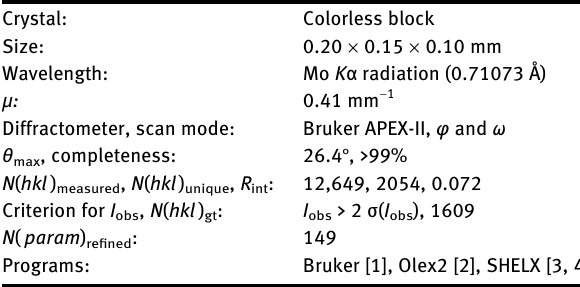
Table  : Data collection and handling. Crystal: